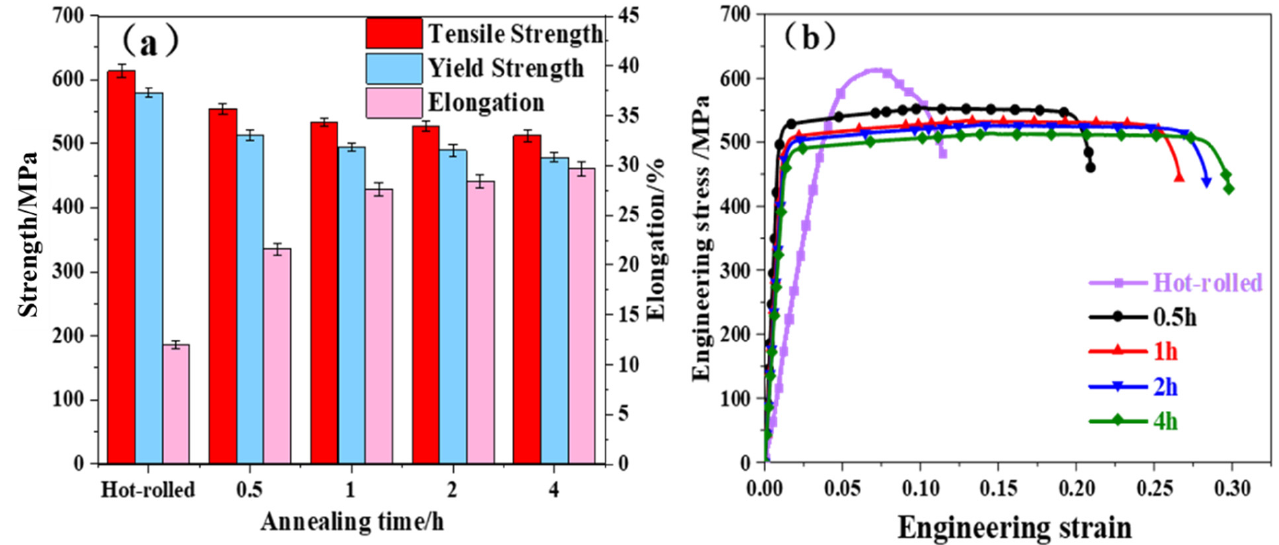
Figure 8. Tensile properties of TA10 annealed sheets: ( a ) elongation and strength; ( b ) stress–strain curves.